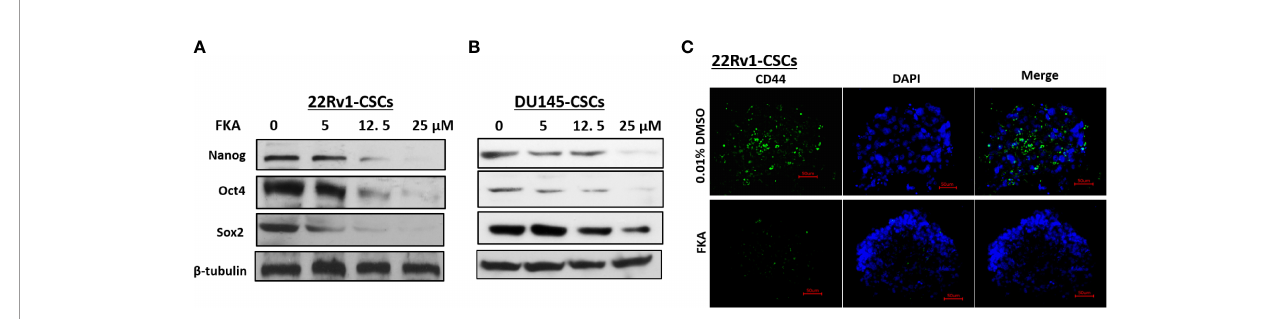
FIGURE 2 | Effects of FKA on the expression of stem cell markers in prostaspheres. (A, B) FKA treatment of prostaspheres generated from DU145 and 22Rv1 CSCs at the secondary generation at indicated concentrations for 24 h decreased the expression of Nanog, Oct4, and Sox2. (C) FKA treatment at 12 µM for 24 h signi fi cantly reduced the number of CD44- positive cells in prostaspheres generated from 22Rv1